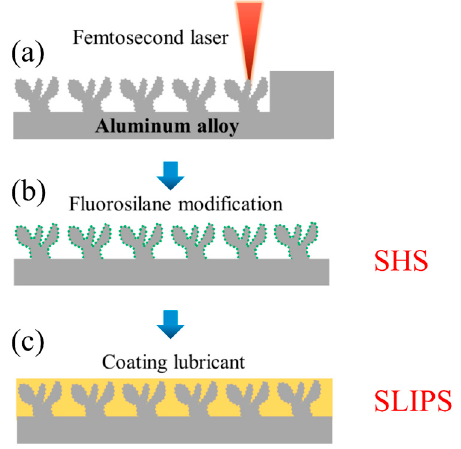
Figure 1. Schematic diagram of the preparation process: ( a ) Femtosecond laser processing; ( b ) Fluorosilane modification; ( c ) Infusion of the lubricant.